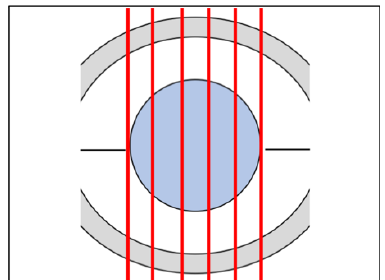
Figure 2. Schematic representation of the cornea, dorsal view; the central area (blue), identifies the area of the induced lesion in the cornea; the red lines represent the points for the collection of the histological slides. Serial cuts have been performed at regular intervals of 1000 μm from each (red lines) to examine each cornea in the totality of its diameter: the protocol provided the elimination of a first portion of the sample considered not significant for the evaluation of the lesion area. From each cornea, transverse sections (slides) of 5 μm thickness were obtained at every cutting point using a Leica RM2035 microtome.